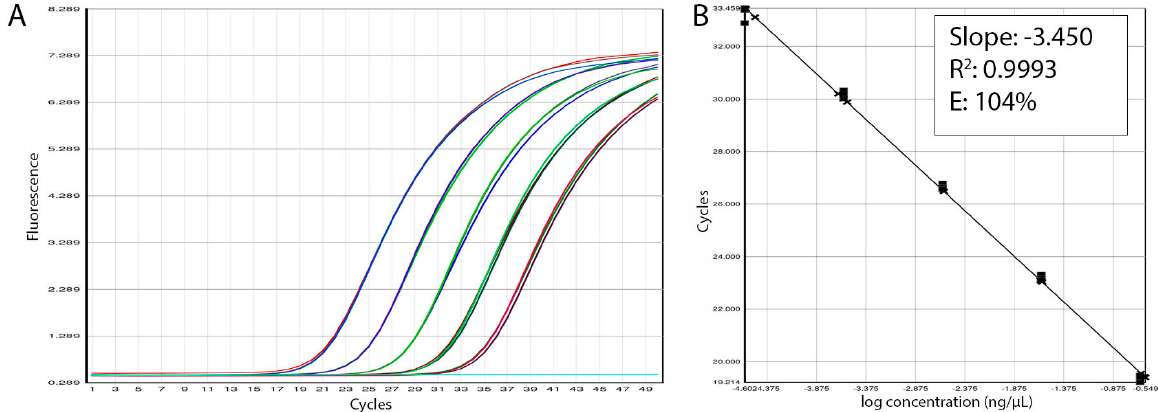
Figure 3. ( A ) A standard curve created using serial dilutions of DNA extracted from USA-sourced Carica papaya . ( B ) Linearity and efficiency calculations from the standard curve.